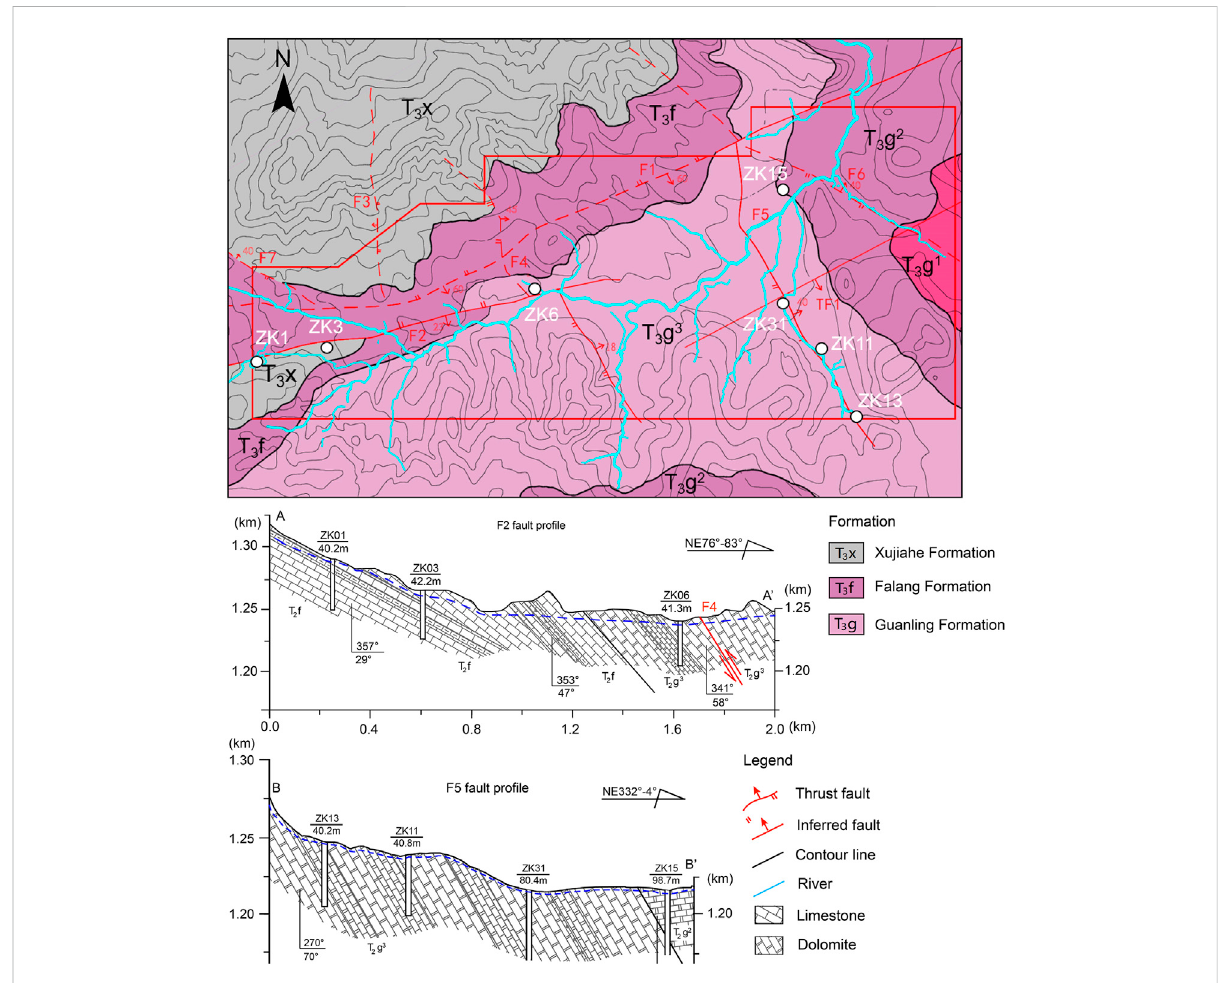
FIGURE 2 Regional lithology and geological structure of the study